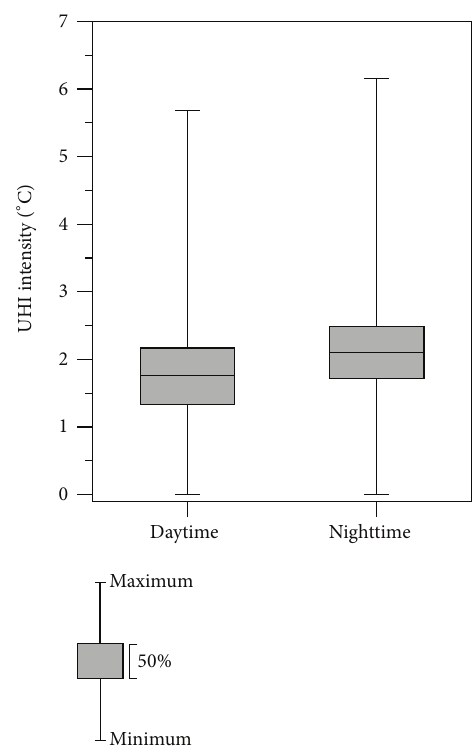
Figure 6: Nighttime and daytime urban heat island intensity (UHII).